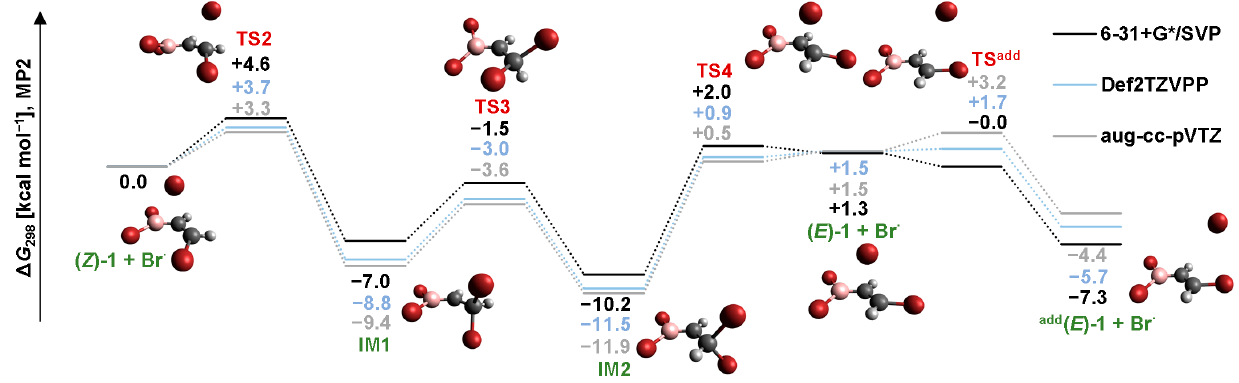
Figure 5. MP2 Gibbs free energy profile for bromine radical addition to the “bromine end” of ( Z )-1 . Total electronic energies from Def2TZVPP and aug-cc-pVTZ basis sets were corrected by 6-31+G*/SVP contributions. For a key to atom color scheme, cf. caption of Figure 1.